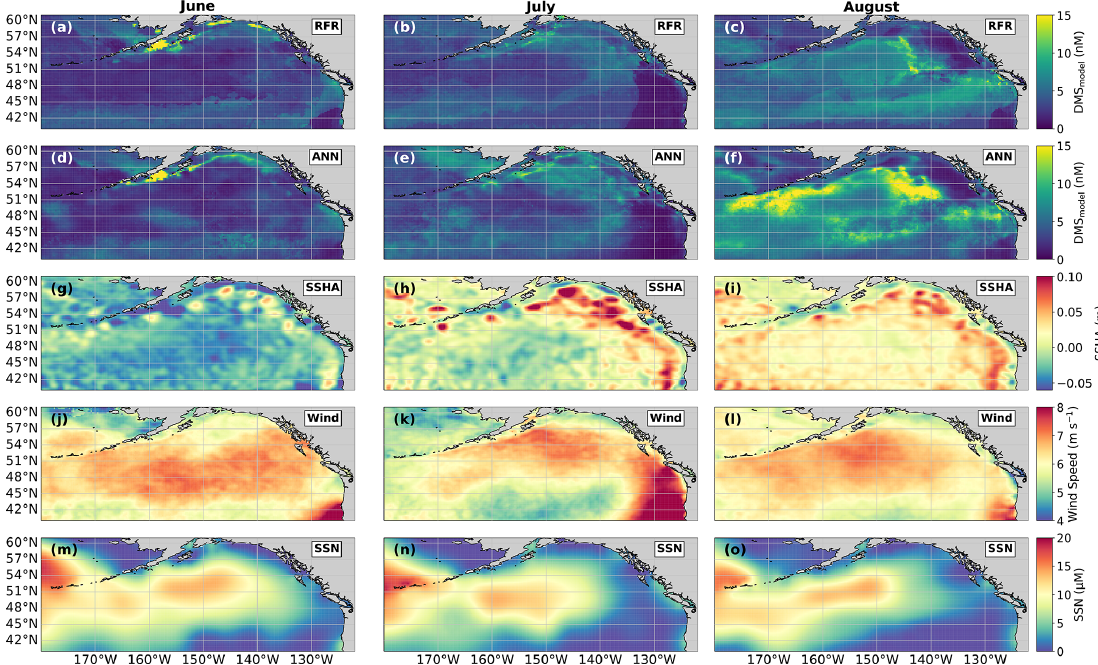
Figure 9. Predicted spatial and temporal (June–August) DMS distributions in relation to underlying oceanographic variables. DMS concen- trations predicted from (a–c) the random forest regression (RFR) and (d–f) the artificial neural network (ANN) ensemble models are mapped alongside the monthly averaged (g–i) sea surface height anomalies (SSHAs), (j–l) wind speed (Wind), and (m–o) sea surface nitrate (SSN) for each month. Colormap ranges are restricted to illustrate trends, with at most 1.5% of the data beyond the colorbar